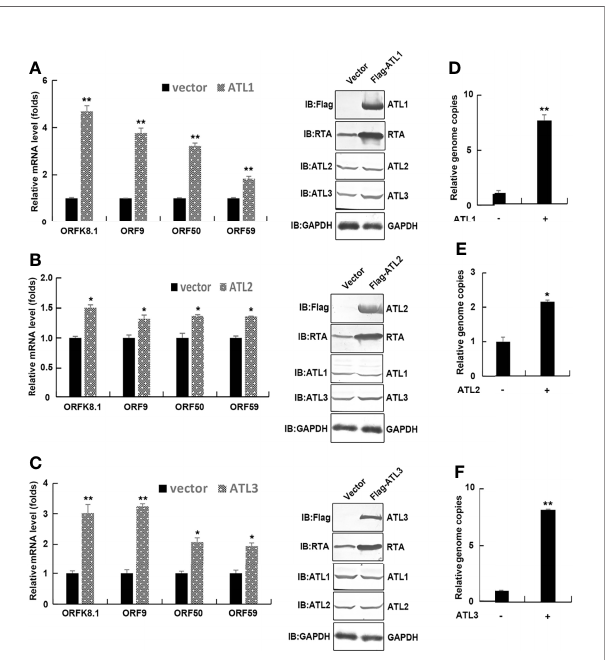
FIGURE 1 | ATLs overexpression promotes spontaneous KSHV lytic reactivation in iSLK. rKSHV.219 cells. iSLK.rKSHV.219 cells were transfected with vector, ATL1, ATL2 or ATL3 respectively. Forty eight hours later, mRNA levels of KSHV lytic genes ORFK8.1 , ORF9 , ORF50 , and ORF59 were measured by RT-qPCR, with normalization to actin using the DD CT method. Proteins were detected by western blot with indicated antibodies (A – C) . Viral DNA in the media was quanti fi ed using qPCR, with normalization to an added plasmid FAM105B using the DD CT method (D – F) . Data are presented as means of three technical replicates (n = 3, group values are indicated by mean ± SEM; *p <0.05; **p